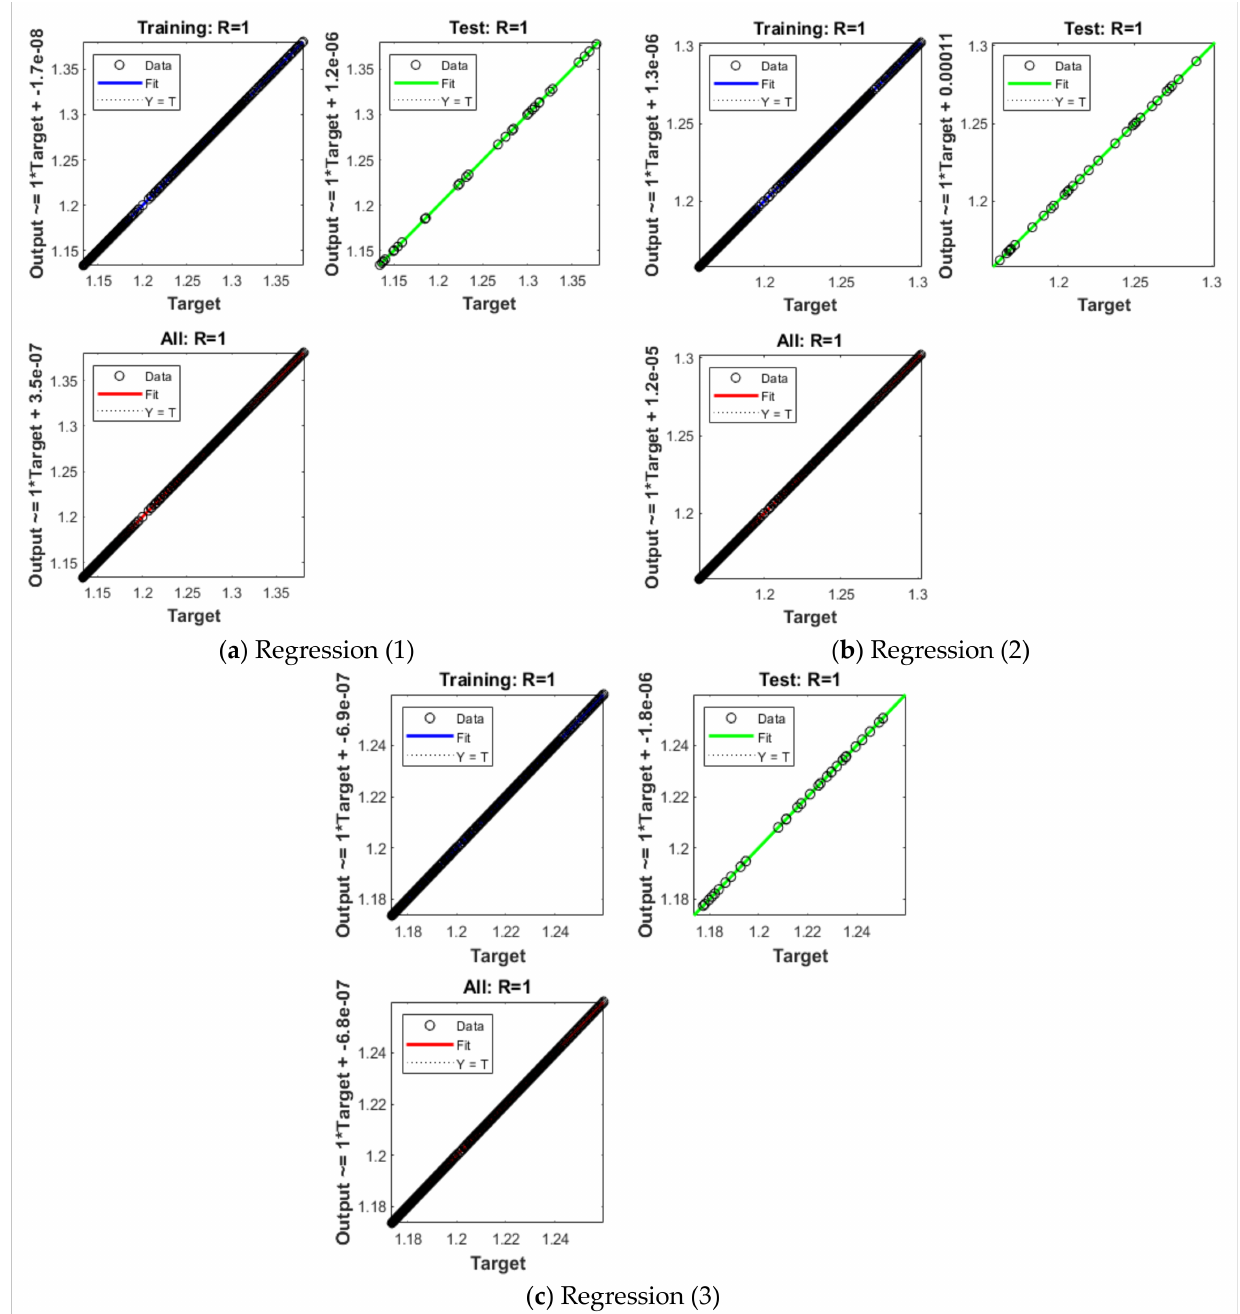
Figure 5. The performances of the regression for the dynamical